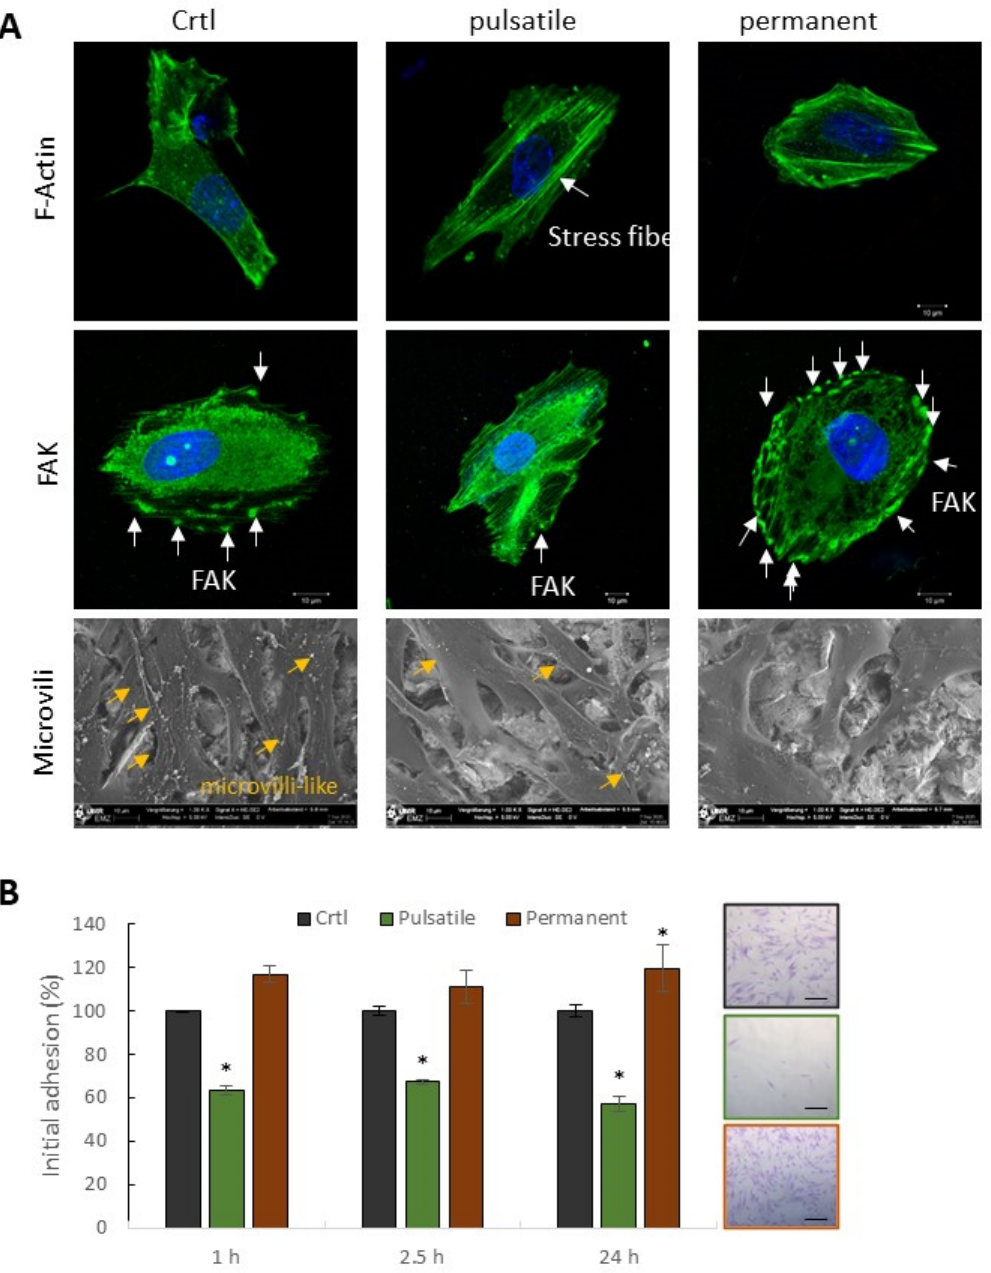
Figure 6. Morphological and adhesin-related alterations. ( A ) Actin cytoskeleton (F-actin, upper row), focal adhesion kinase (FAK, middle row), and microvilli (lower row) visualization after three days of pulsatile or continuous electrical stimulation in comparison to non-stimulated ASCs. After pulsatile stimulation, a boosted actin stress fiber formation (green) was detectable. FAK molecules are significantly reduced after pulsatile stimulation, while continuous stimulation increases the amount of FAK in the cell periphery. F-actin and FAK were counterstained with Hoechst in blue to mark the nuclei. Scanning electron images indicate the microvilli-like structures on the cell surface, which are reduced in pulsatile stimulated cells and seem largely absent in continuously stimulated cells. ( B ) Comparative analyses of initial adhesion of non-stimulated (control), pulsatile, and continuous electrically stimulated ASCs after three days. Three adhesion time points (1, 2.5, 24 h) were chosen to monitor the adhesion process. Right: Exemplarily pictures of adherent cells after one h. Mean ± SD, n=3, * p < 0.05. Scale bar: 100 µm.